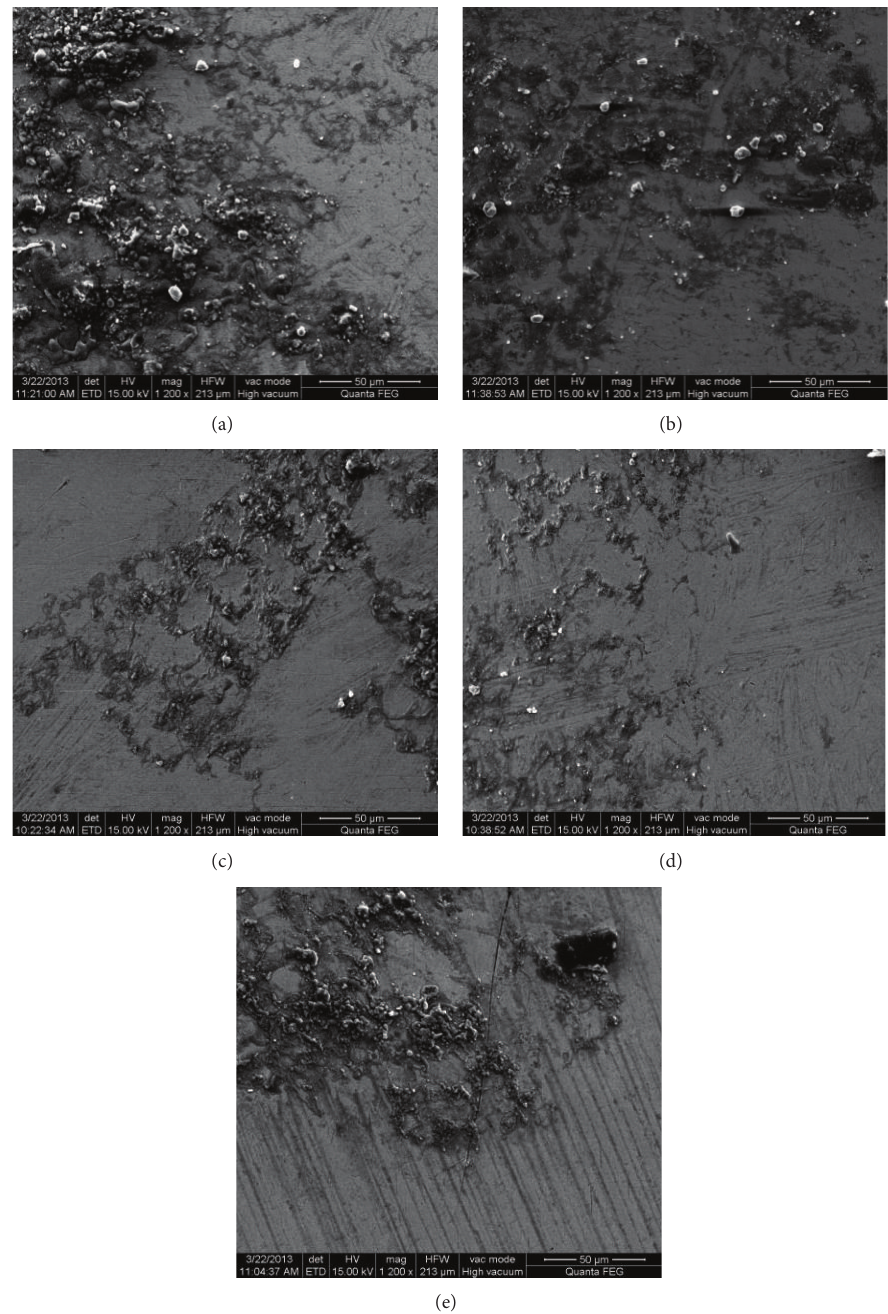
Figure 11: SEM image of metal ball used in four-ball tester at pass load of (a) mineral oil, (b) mineral oil + 0.5% wt graphite, (c) mineral oil + 0.1% MWNT, (d) mineral oil + 0.5% MWNT, and (e) mineral + 0.6%